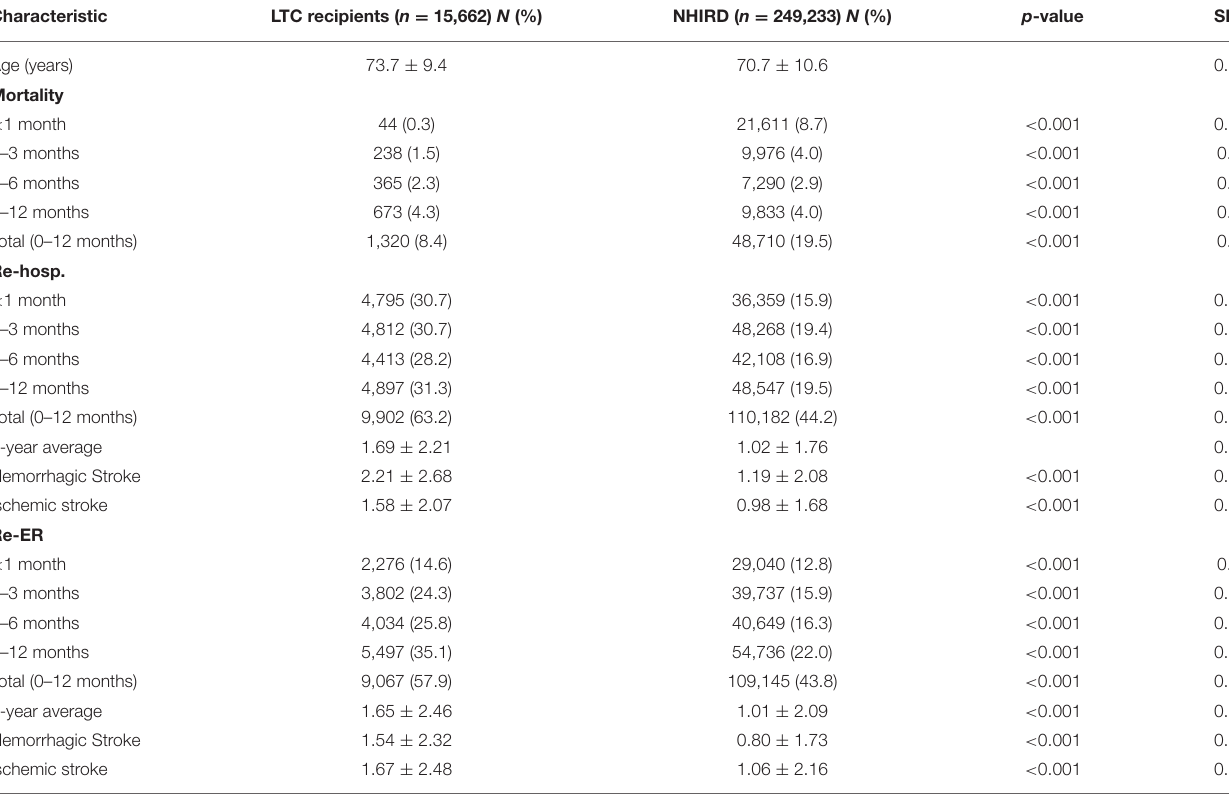
TABLE 3 | The mortality and follow-up indices (rehospitalization and re-emergency) of patients with stroke receiving LTC among the National Health Insurance Research Dataset (NHIRD) in Taiwan during 2011–2016.